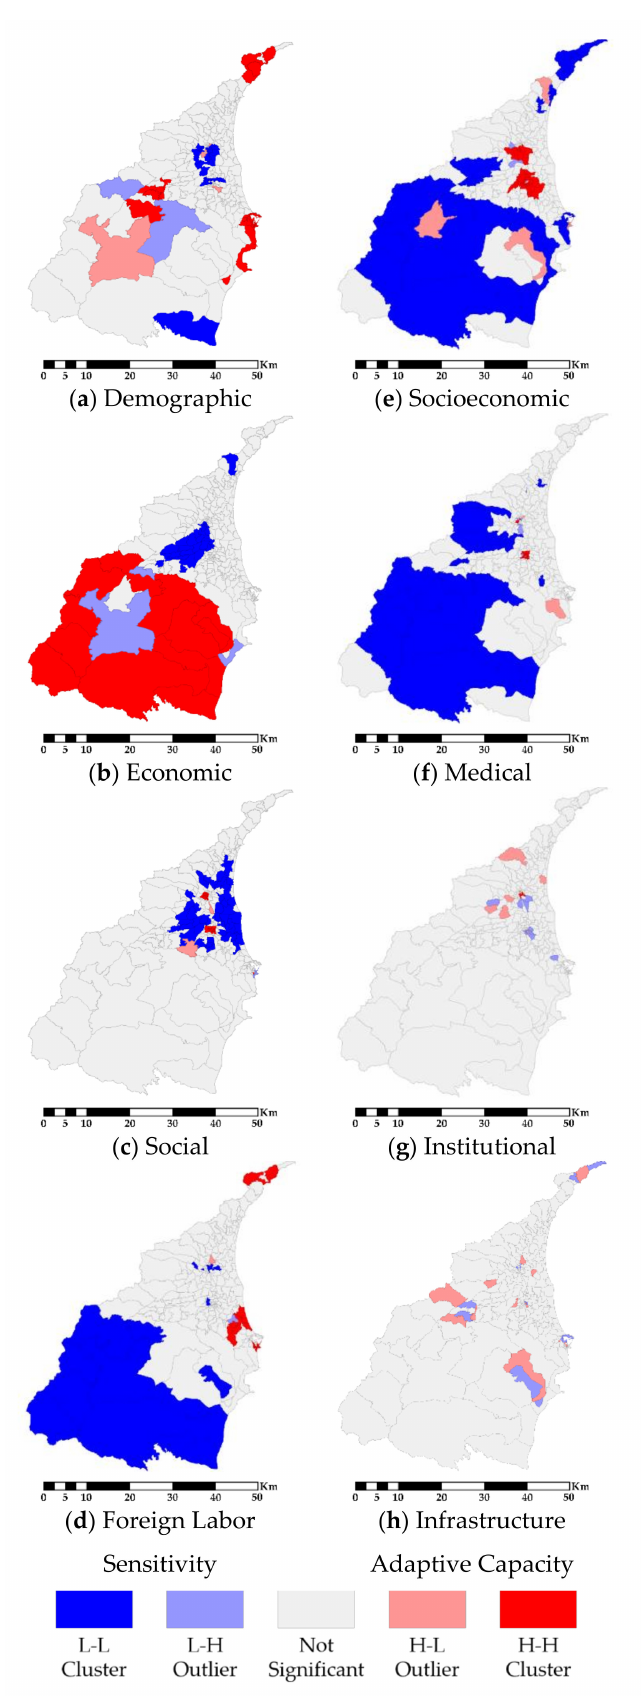
Figure 3. LISA results of all principal